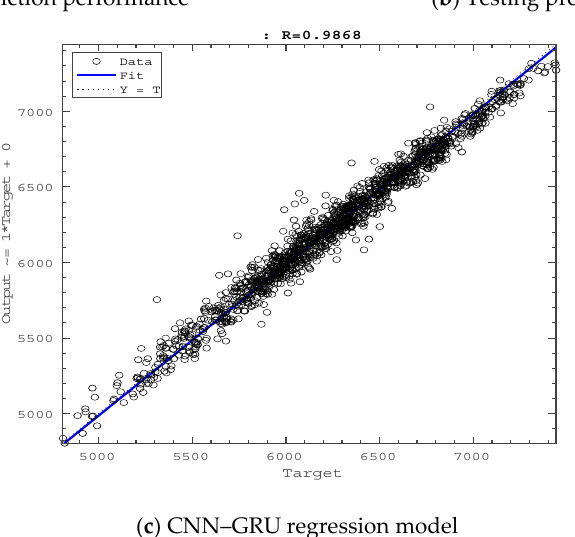
Figure 11. Hybrid CNN–GRU model prediction performance for the Jeddah load: ( a ) training and testing, ( b ) testing, and ( c ) regression plot.